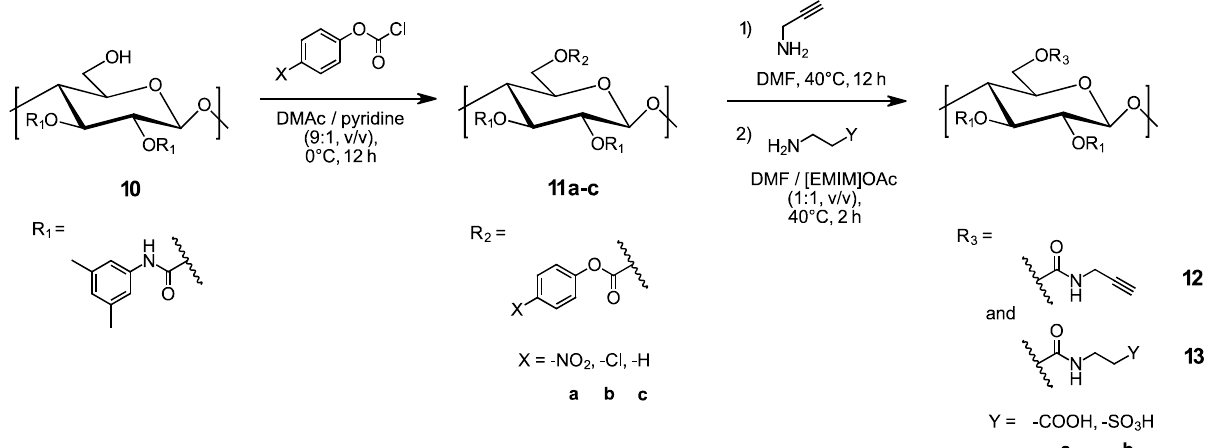
Molecules 2022 , 27 , x FOR PEER REVIEW Figure 2. Synthesis of regioselectively substituted, mixed cellulose carbamates by homogeneous aminolysis of the respective carbonate derivatives in DMF or DMF/[EMIM]OAc media.